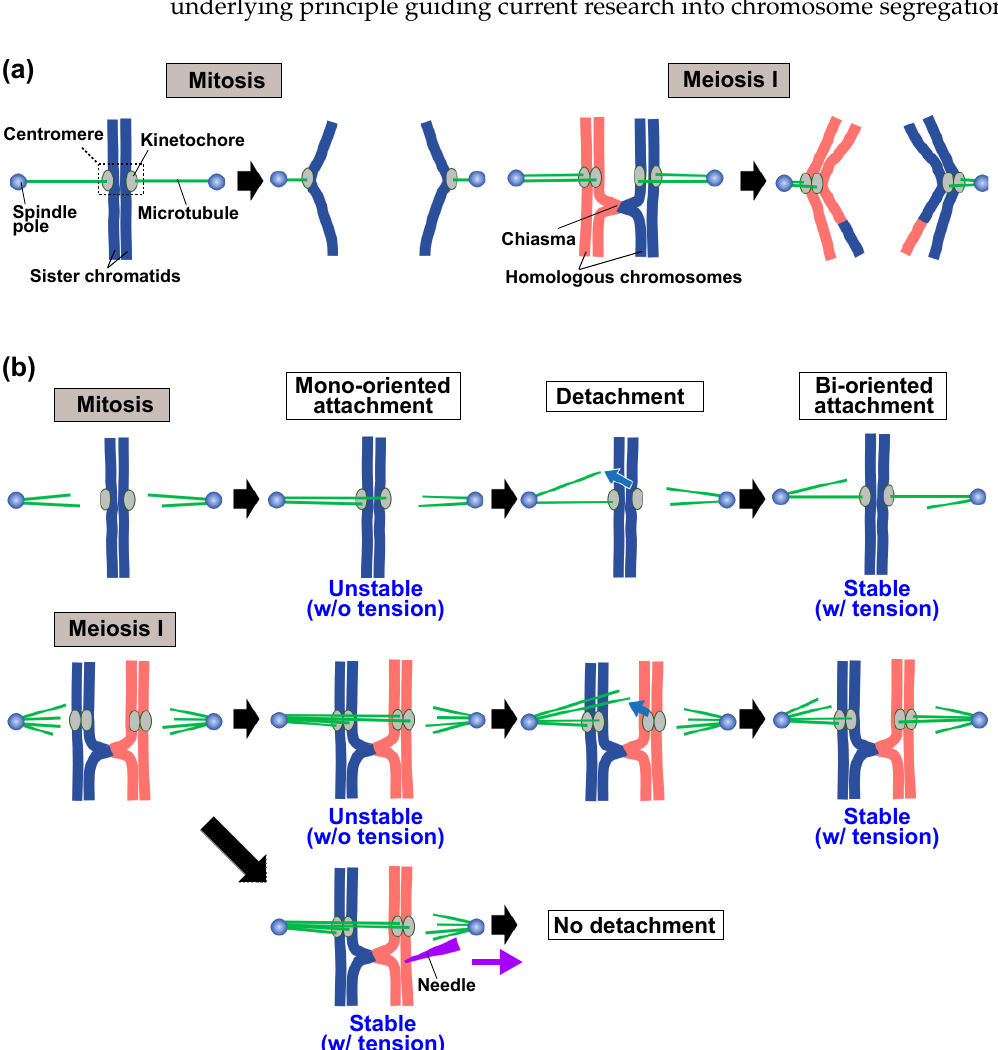
Figure 1. Chromosome segregation in mitosis and meiosis I, and correction of chromosome attachment to the spindle. ( a ) Chromosome attachment to the spindle and chromosome segregation during mitosis and meiosis I. In mitosis, sister chromatids are attached to both spindle poles by microtubules (MTs) that extend from the poles via kinetochores assembled on centromeres, resulting in segregation of the sister chromatids to opposite poles (mitosis). In meiosis I, homologous chromosomes linked by chiasmata are attached to opposite poles, resulting in segregation of the homologous chromosomes (meiosis I). ( b ) The relationship between elimination of improper attachments and tension generated at the kinetochores. When both sister chromatids in mitosis or homologous chromosomes in meiosis I are attached to the same pole, insufficient tension is generated and attachment is unstable (mono-oriented attachment). As a result, chromosomes become detached from the spindle (detachment). The chromosomes again interact with the spindle MTs. When they are bi-oriented, tension is generated, resulting in stabilization and retention of the attachments (bi-oriented attachment). When anti-poleward forces are exerted on mono-oriented homologous chromosomes by an ultra-fine needle, chromosome detachment does not take place (meiosis I, lower row). Blue arrows indicate MT detachment from kinetochores, the purple arrow indicates the force exerted by the needle, and black arrows indicate transition of the attachment state. For simplicity, only one kMT attached to each single kinetochore is